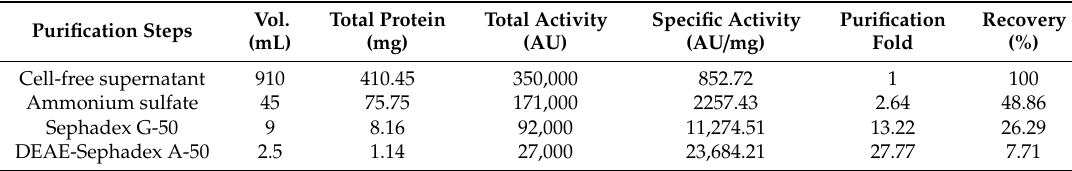
Figure 3. Gel filtration elution summary of peptide MS07 from ( a ) the Sephadex G-50 (2.5 × 85 cm) and ( b ) the DEAE-Sephadex A-50 column (1.5 × 37 cm). Stability of ( c ) pH and ( d ) temperature on the activity of peptide MS07. Table 3. Purification table of peptide MS07.